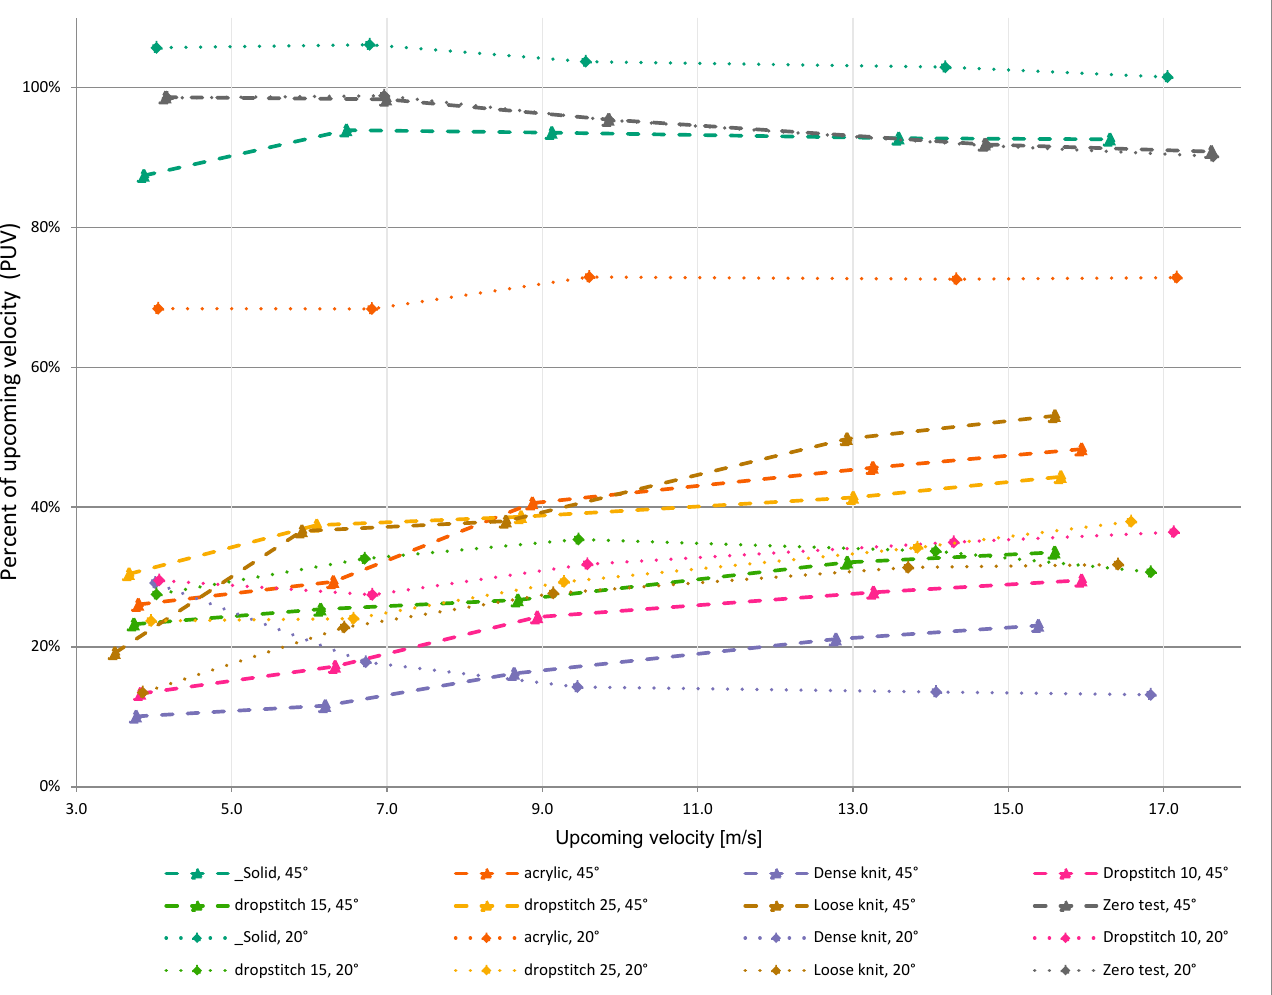
Figure 12. Percent of upcoming velocity (PUV) for the screens positioned at an angle of 45° and 20° to the wind.